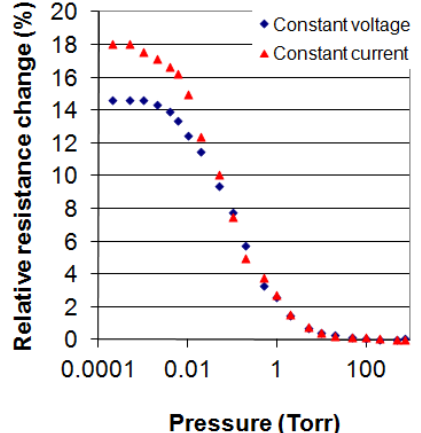
Figure 9. Relative resistance change versus pressure of a medium membrane device measured at about 2 mW in constant voltage (lower curve) and in constant current (upper curve)